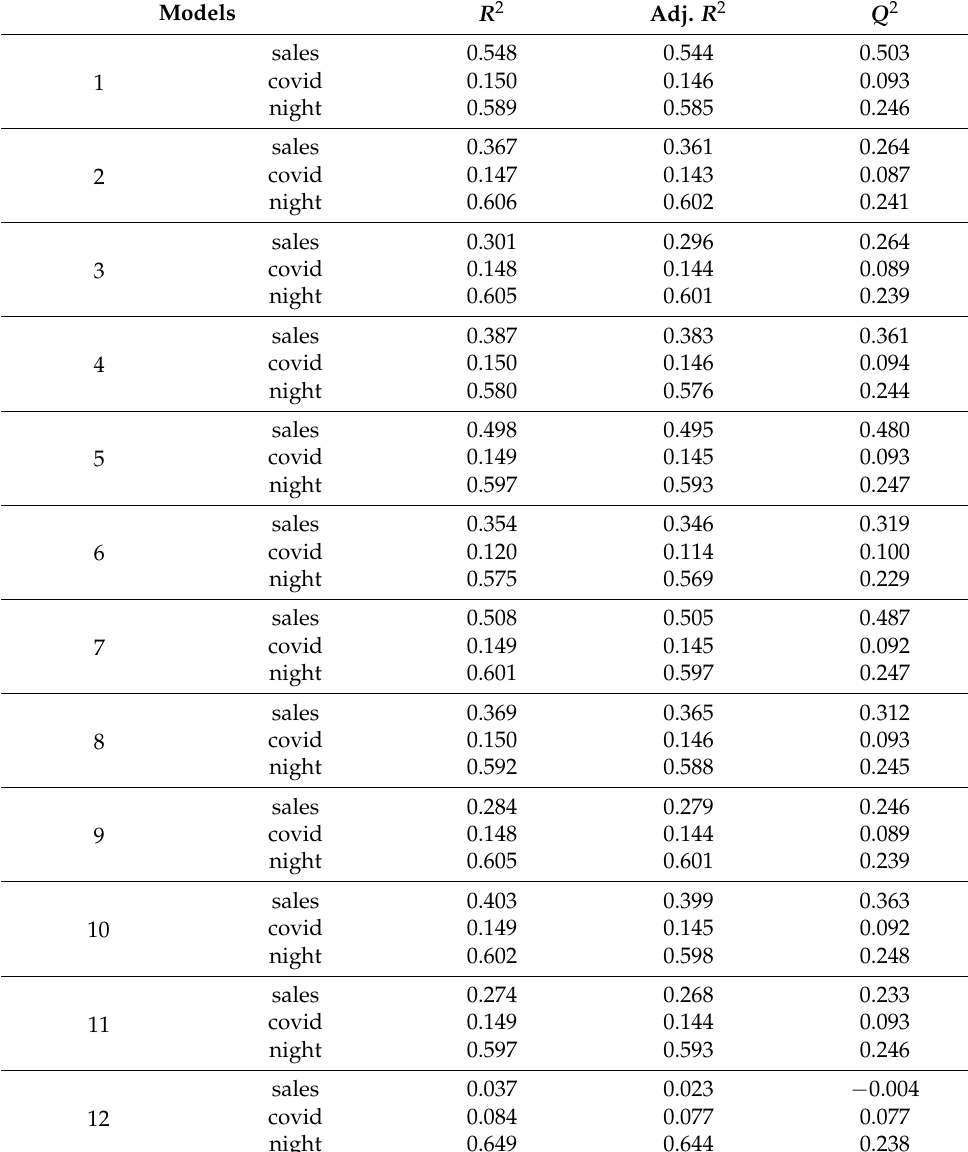
Table 7. Coefficients of determination of the